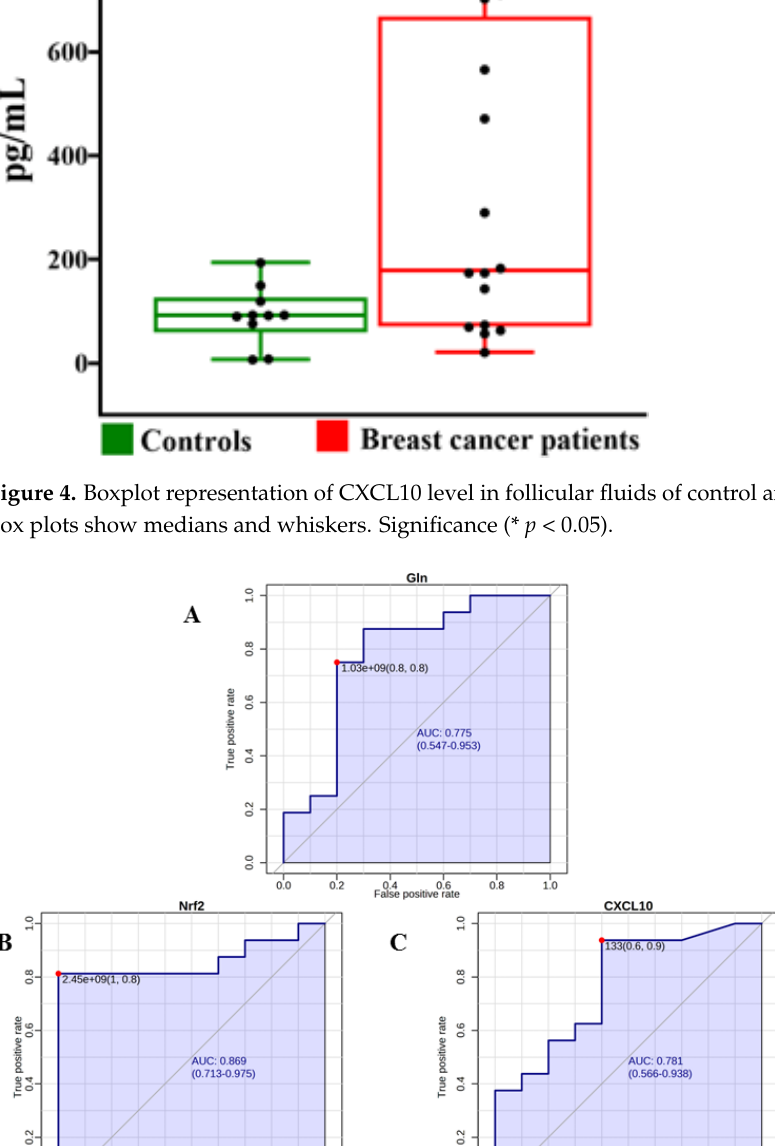
Figure 4. Boxplot representation of CXCL10 level in follicular fl uids of control and BC patients. The